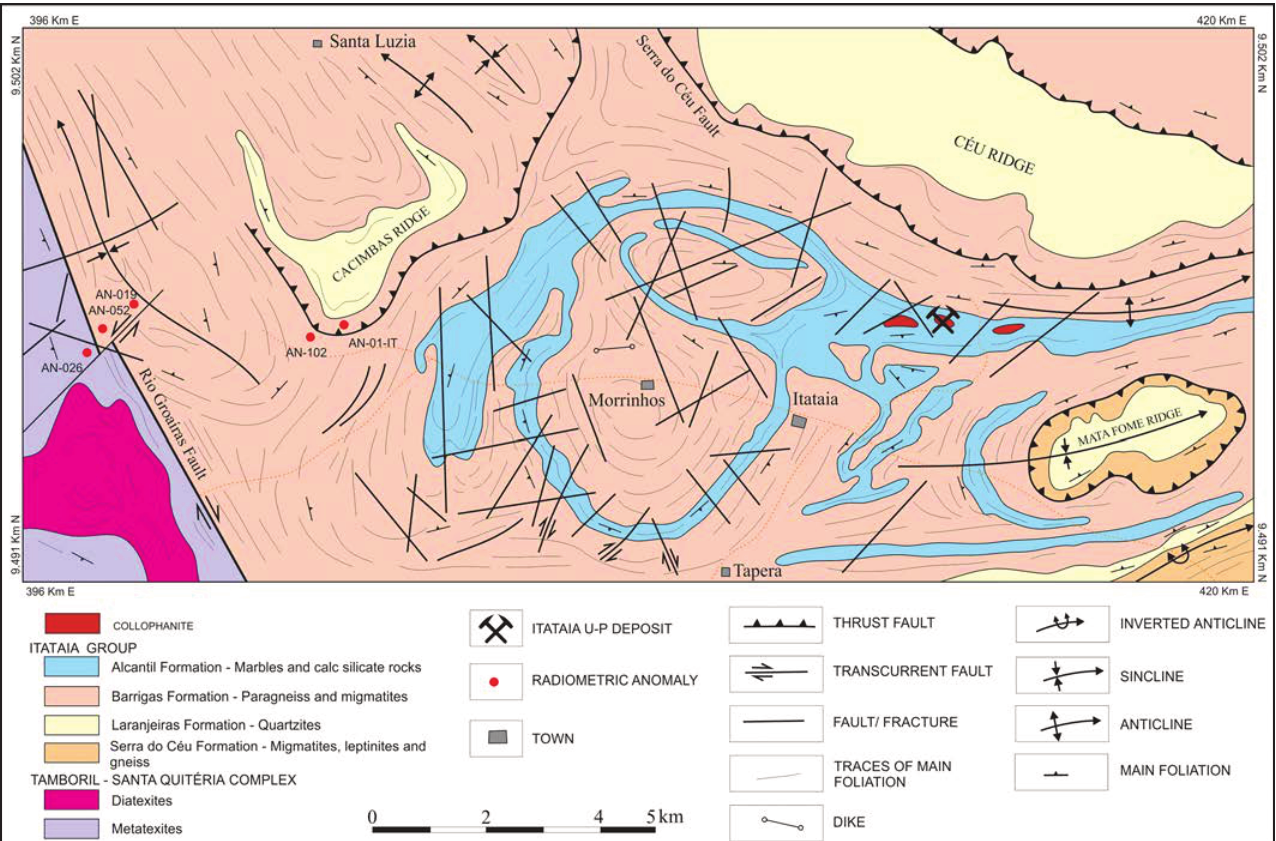
Figure 7 - Geological map with the location of the Itataia U-P deposit (compiled and modified from Mendonça et al. 1980; Angeiras